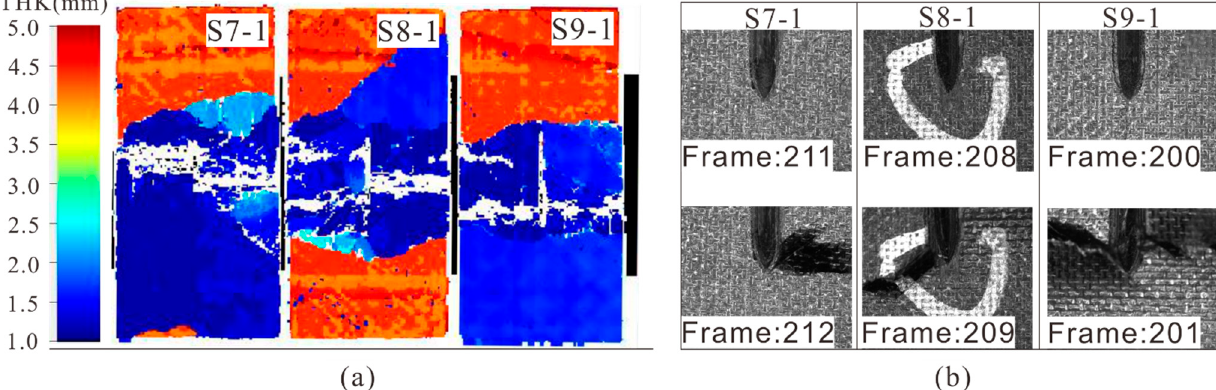
Figure 8. ( a ) C-scan results of specimens with 0° medium cracks after compression and ( b ) Failure modes comparison of S4-1 and S6-1.